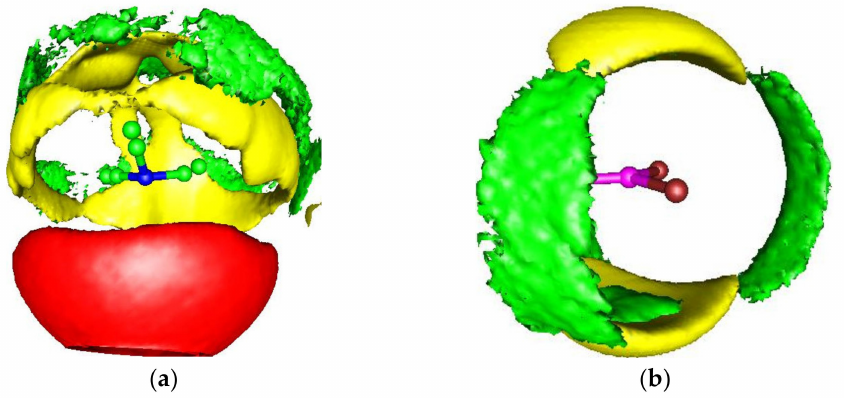
Figure 3. The calculated three-dimensional spatial distributions. ( a ) Cl − (yellow), Al x Cl y3x − y (red), and C 6 H 6 (green) around [Et 3 NH] + ; ( b ) C 6 H 6 (green), Cl − (yellow) around Al x Cl y3x − y